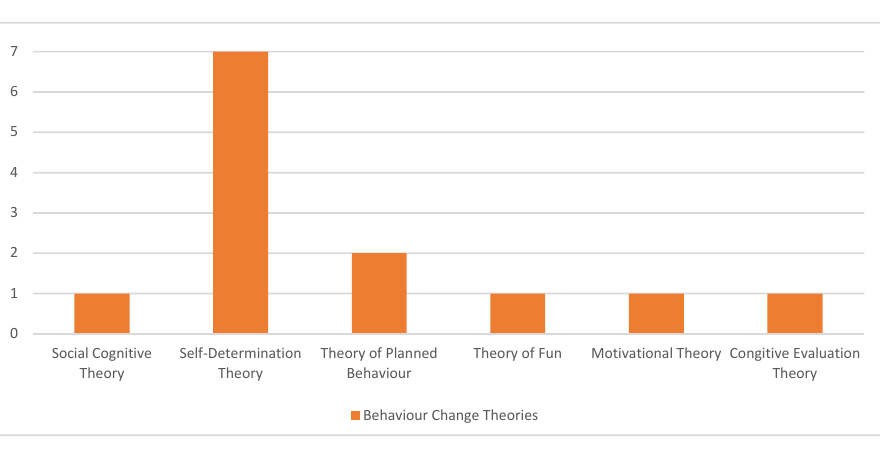
Figure 10. Frequency of behaviour change theories in the Education domain.